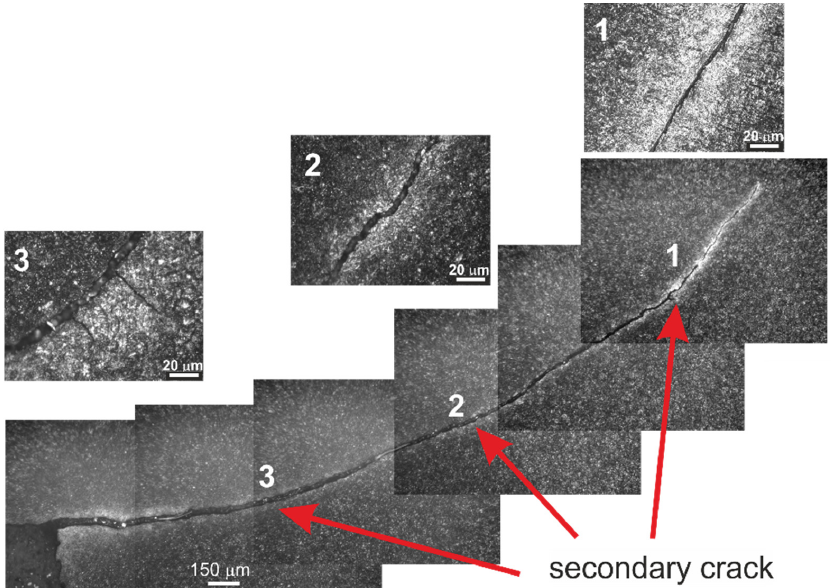
Figure 10. The view of the secondary crack in area C from Figure 5a. 1, 2, 3 indicate the areas that were have been enlarged for better